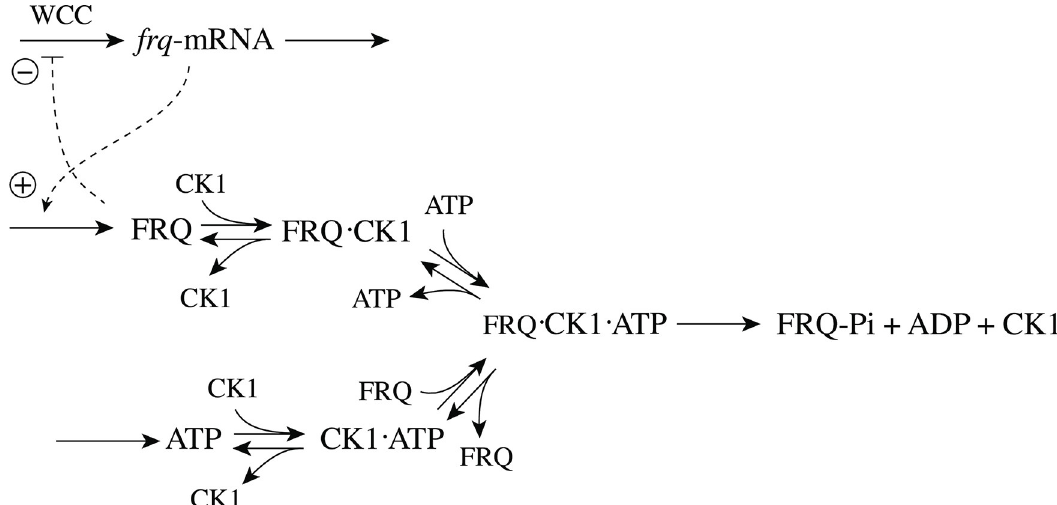
Fig 64. Central transcriptional-translational negative feedback loop of the Neurospora circadian clock. In the presence of FRQ the transcription factor White Collar Complex (WCC) is phosphorylated, which leads to its inhibition by FRQ and thereby suppressing FRQ synthesis. FRQ on its side is phosphorylated, which moves the inhibitory FRQ form out of the loop and leads to its eventually to its degradation. The dual-E controller suggests that frq -mRNA is under homeostatic control with respect to variable frq -mRNA